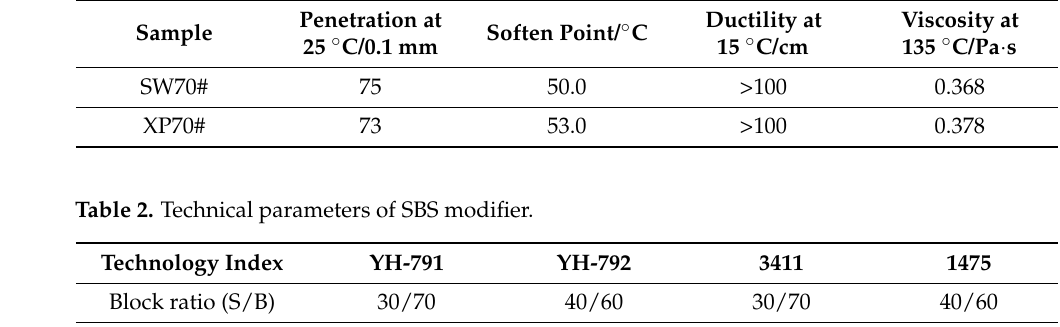
Table 1. Technical indicators of matrix asphalt and aging bitumen.